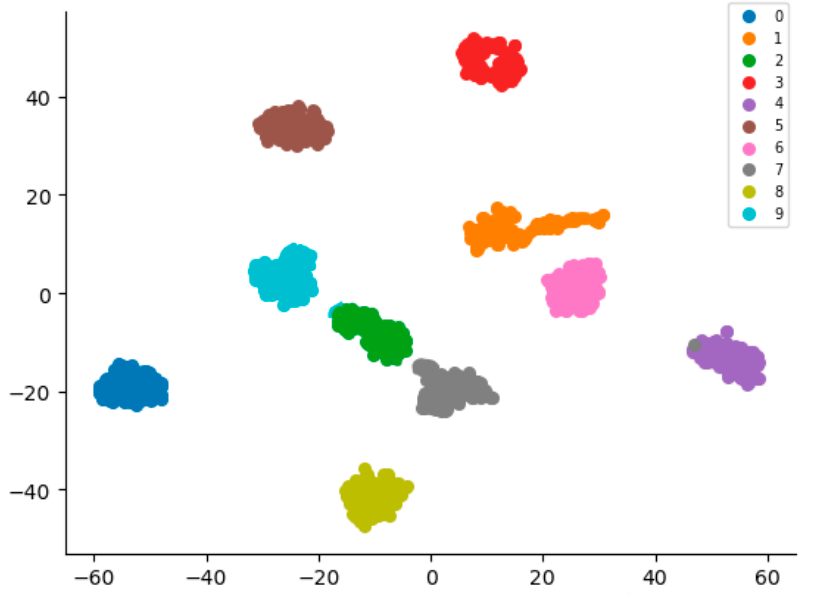
Figure 15. Visualization results of t-SNE in other data sets (from an industrial big data competition).